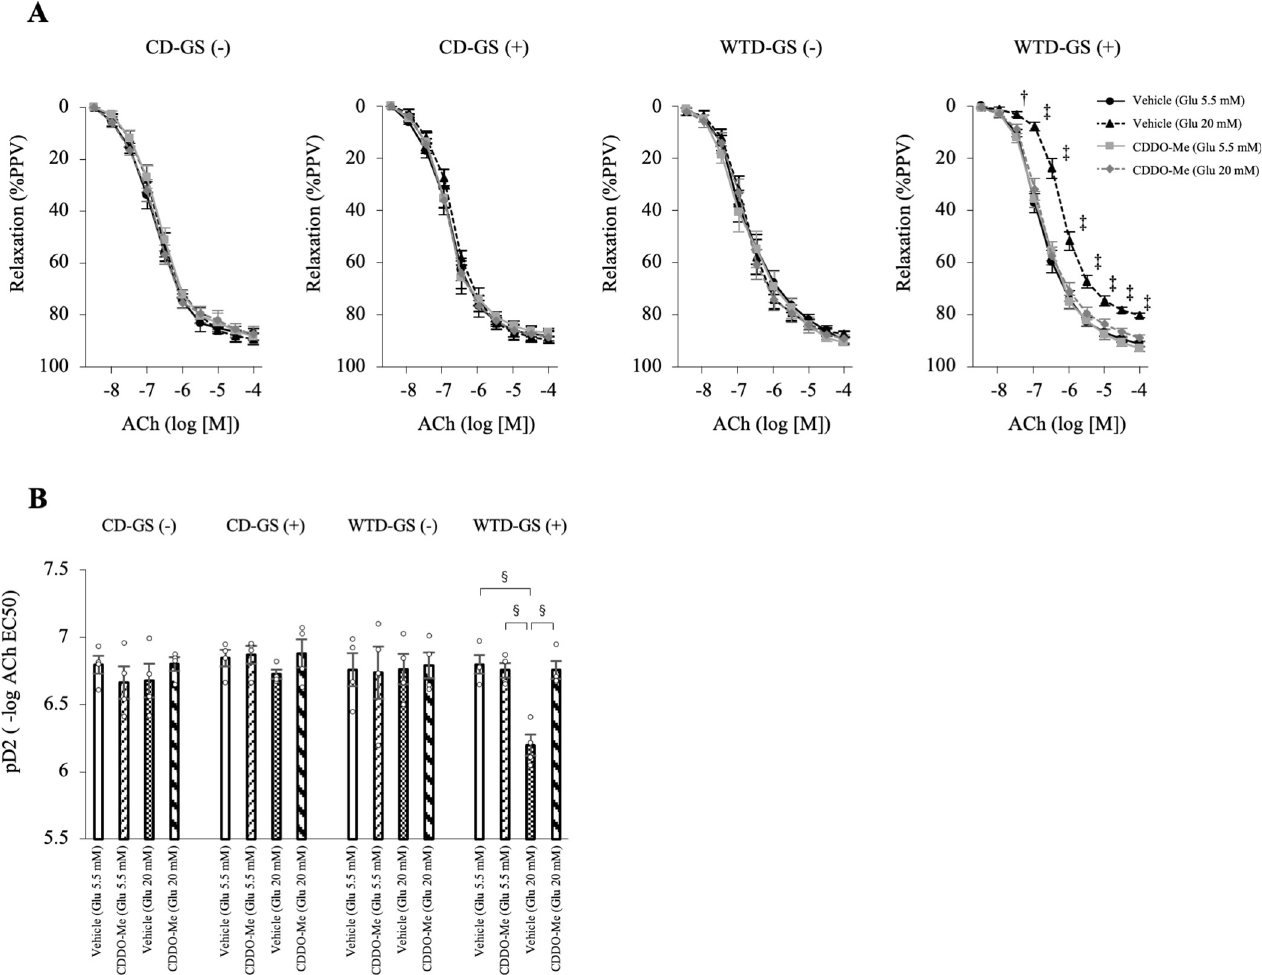
Fig 7. CDDO-Me (3 mg/kg) protects endothelial function in diet-induced obese rats against repeated glucose spikes. Rats were fed a CD or WTD for 13 weeks, treated with vehicle or CDDO-Me for 2 weeks and administered saline or glucose for 1 week. A: Curves of endothelium-dependent relaxation in response to ACh under 5.5 mM glucose or 20 mM glucose conditions. † P < 0.01 and ‡ P < 0.005 compared with the other three groups, one-way repeated- measures ANOVA with the Bonferroni post hoc test. B: Vascular sensitivity, plotted as pD2 (- log of the half-maximal effective concentration [EC50]) of ACh. § P < 0.001, one-way ANOVA with the Bonferroni post hoc test. The data are presented as the means ± SEM. N = 4 rats per group. Glu, glucose; ACh, acetylcholine; CD, control diet; WTD, Western-type diet; GS, glucose